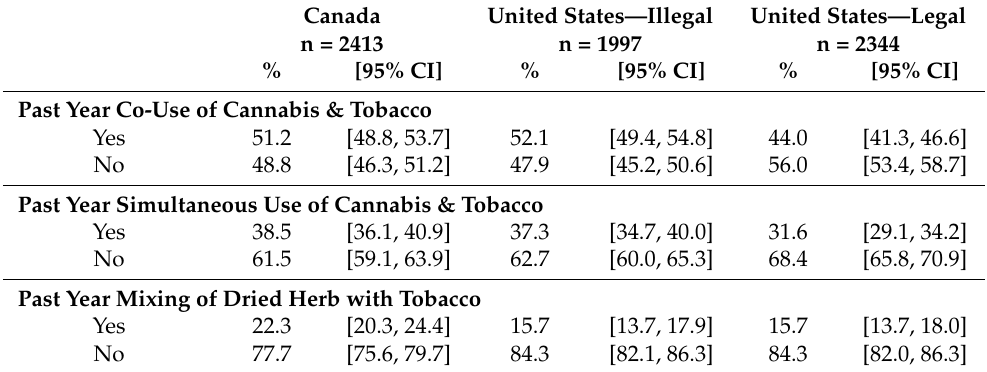
Table 2. Prevalence of co-use, simultaneous use, and mixing among past-year cannabis